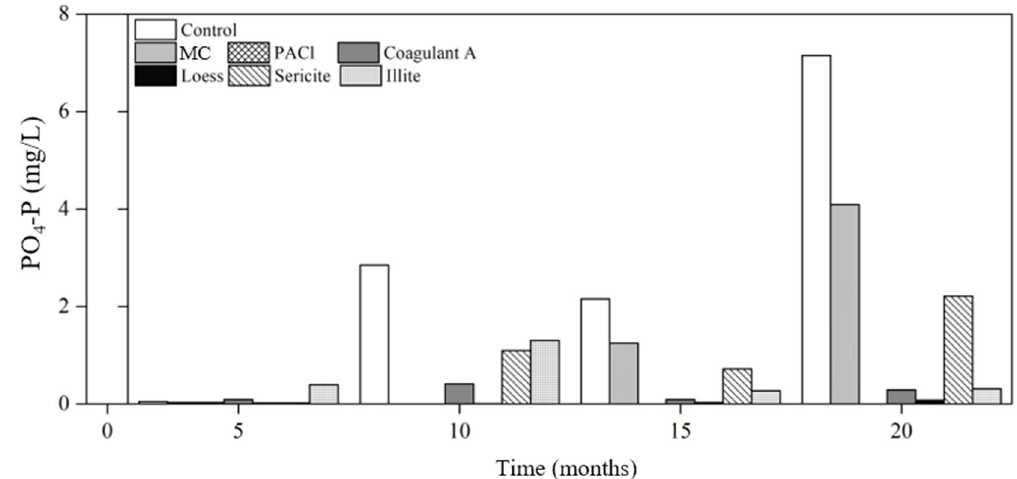
Figure 4. Changes in phosphate concentrations in the control and the treatments with various coagulants and minerals. MC: mineralized coagulant, PACl: polyaluminum chloride, and A: commercial coagulant.